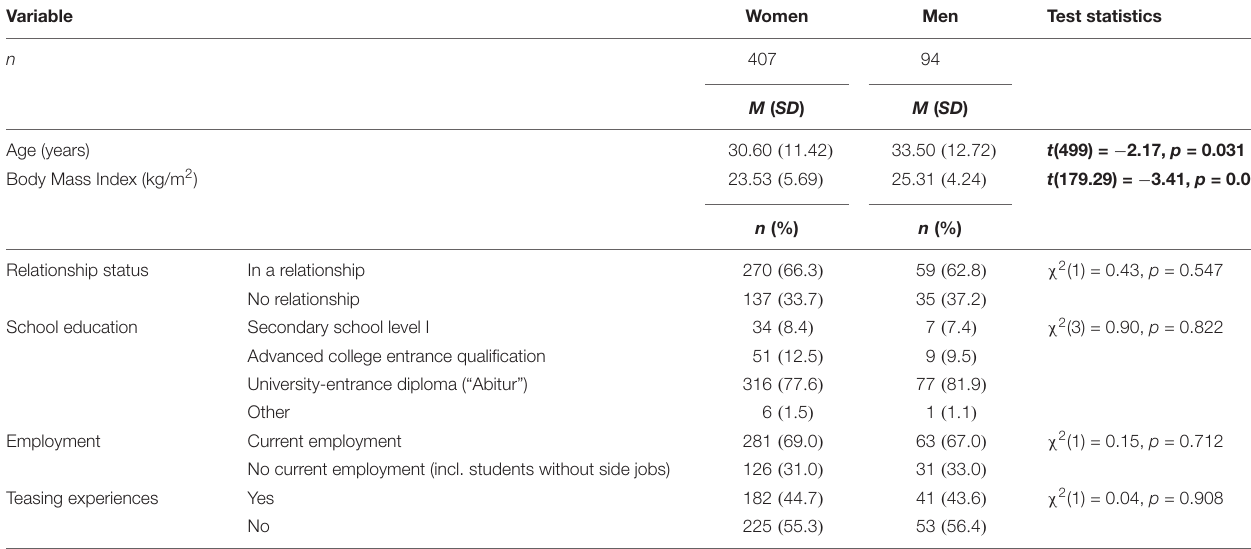
TABLE 1 | Sample characteristics of the female and male subgroup in sociodemographic data. Variable